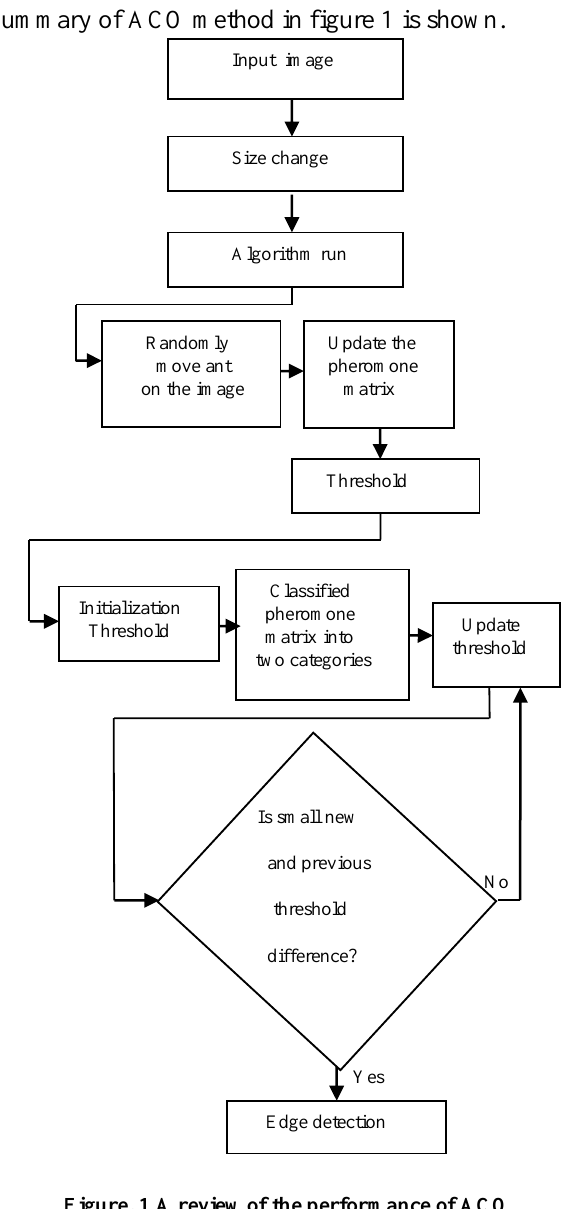
Figure. 1 A review of the performance of ACO